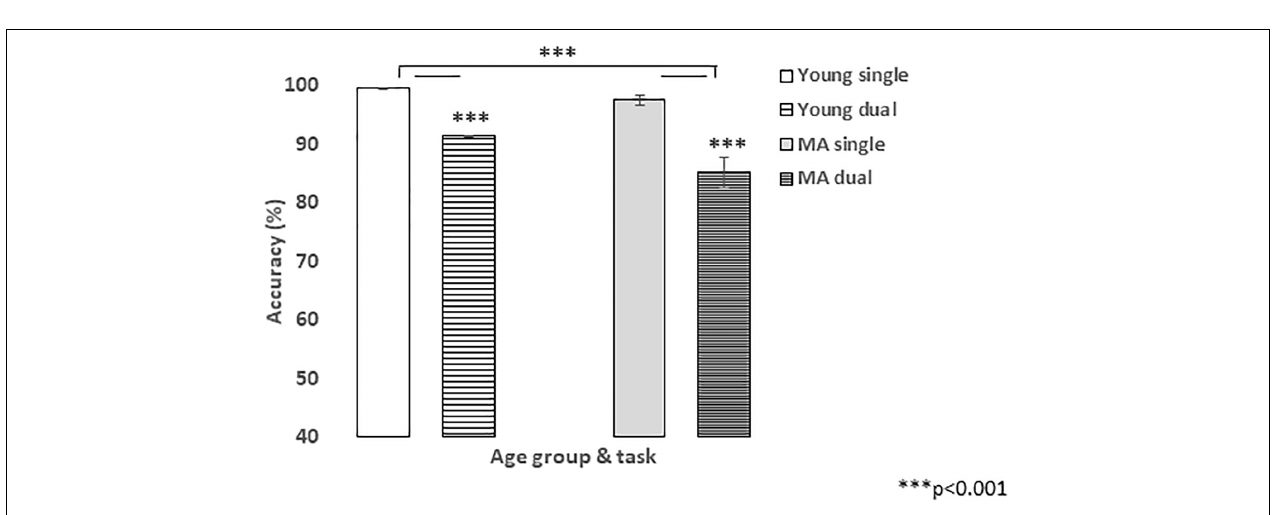
framework (Bernarding et al., 2013; Houben et al., 2013;